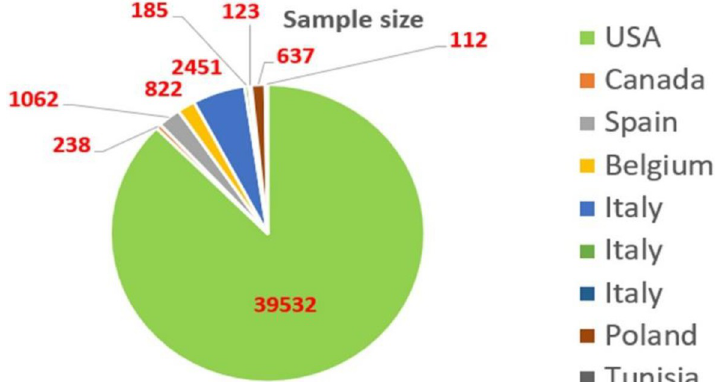
Fig 2. The geographical distribution of